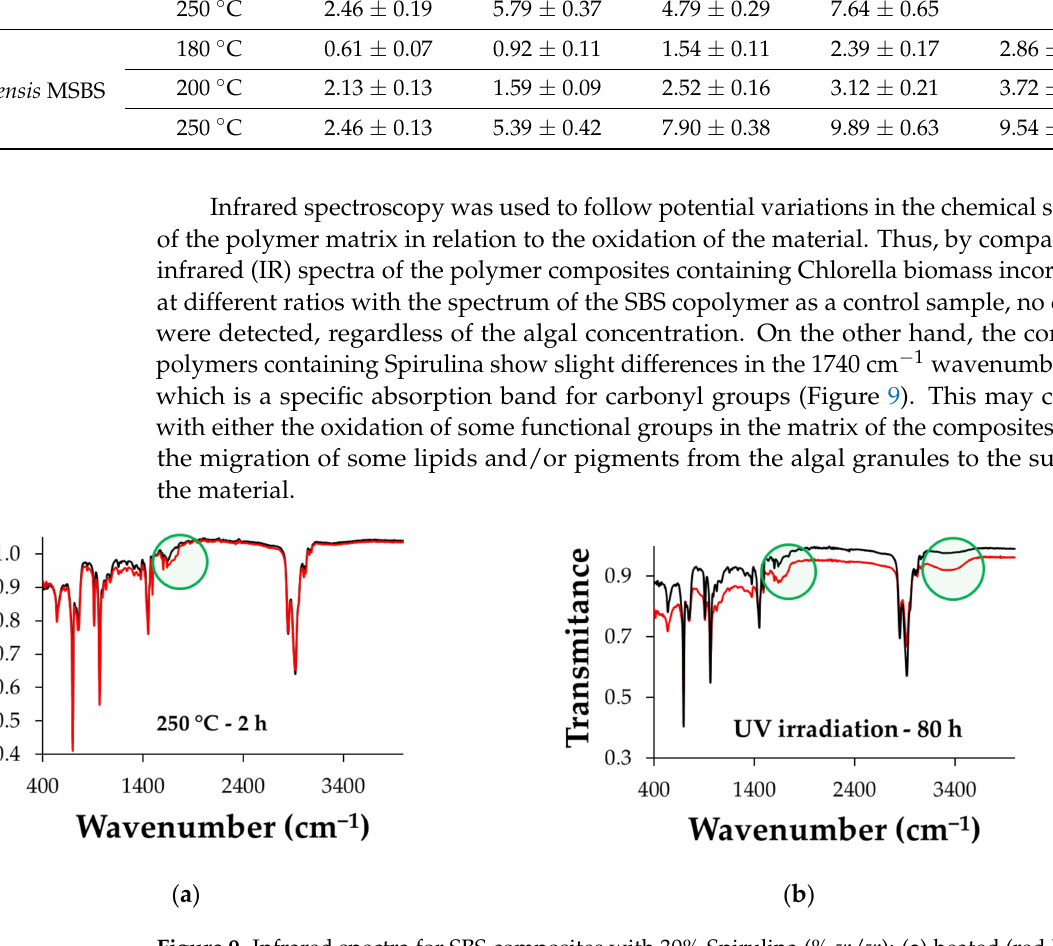
Figure 9. Infrared spectra for SBS composites with 30% Spirulina (% w / w ): ( a ) heated (red line) and unheated (black line) samples, ( b ) irradiated (red line) and nonirradiated (black line)